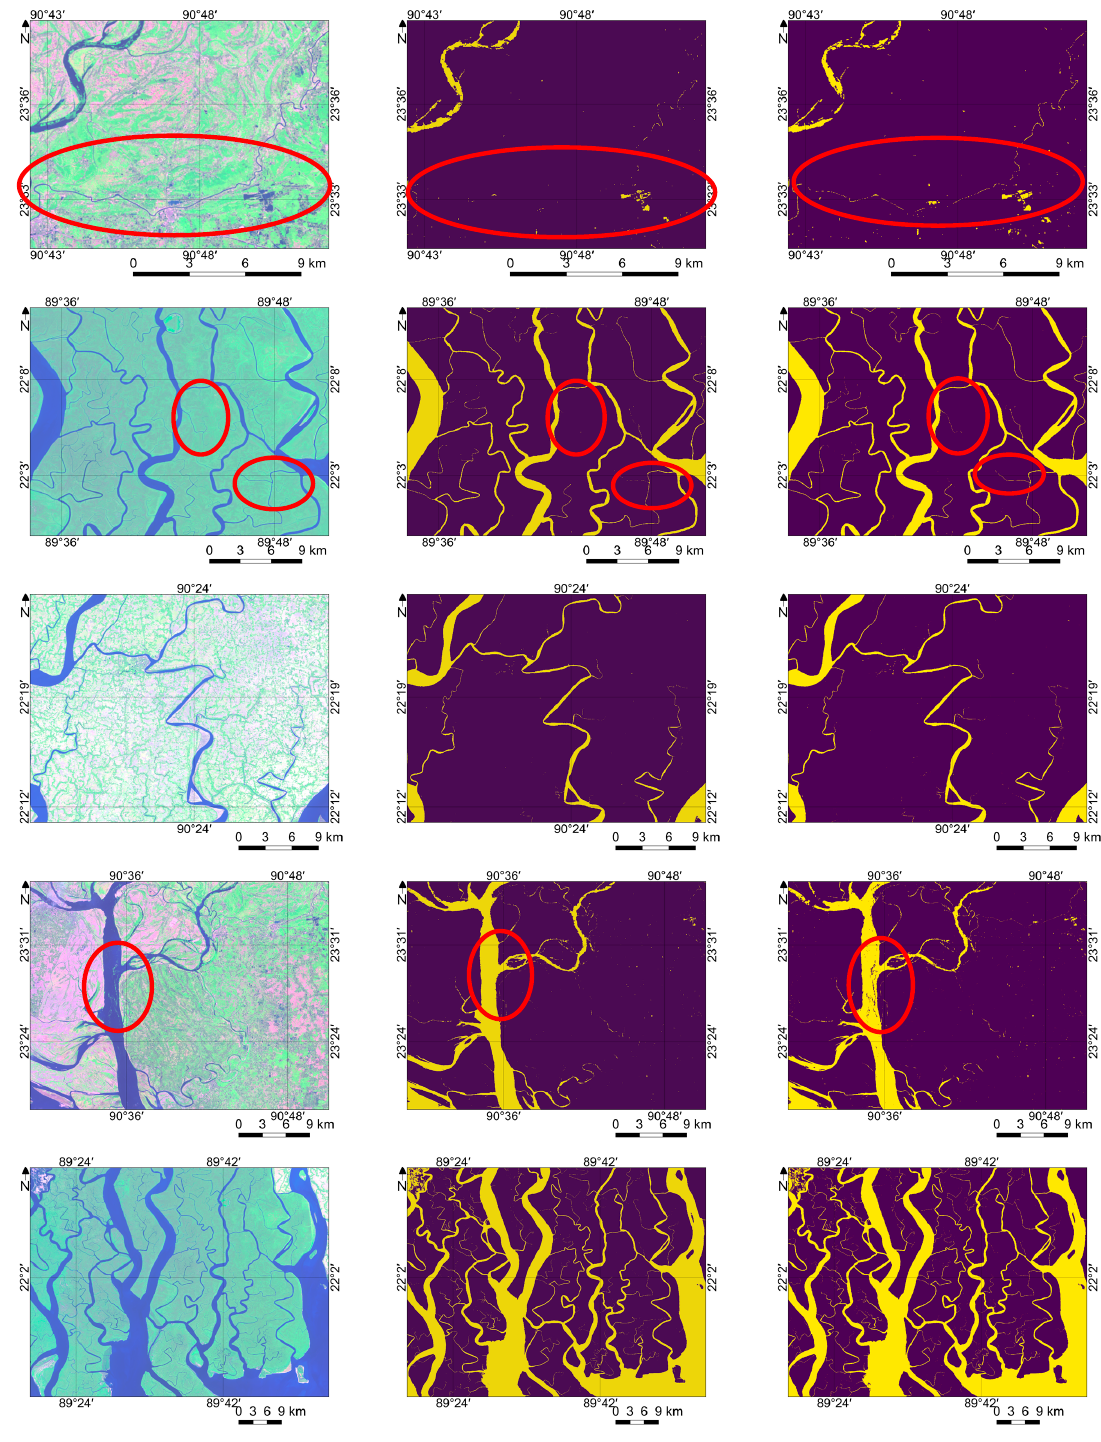
Figure B2. Demonstration of water/non-water region estimation results derived from Figure A2. Demonstration of water/non-water region estimation results derived from Pekel et al. [13] Pekel et al. [13] and proposed method. and proposed